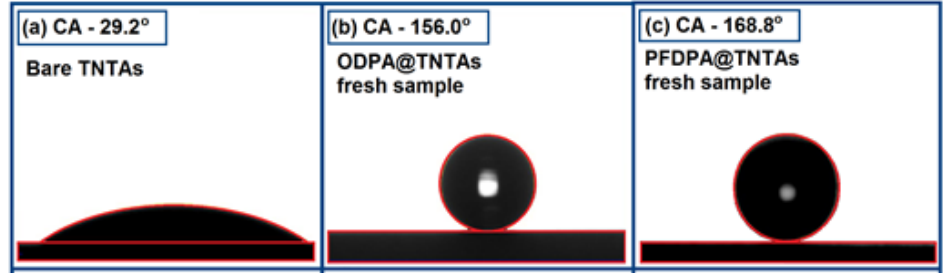
Figure 3. Contact angles of bare TNTA and after functionalization with self-assembled monolayers (SAMs): ( a ) bare TNTAs ( b ) freshly prepared ODPA@TNTAs, and ( c ) freshly prepared